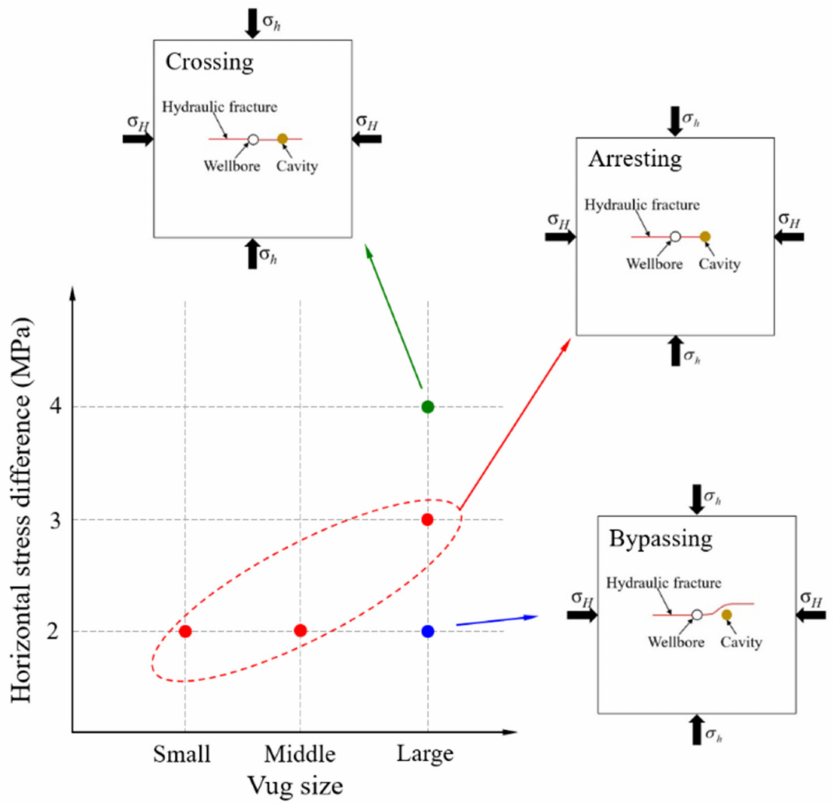
Figure 9. Three patterns of interaction between vug and hydraulic